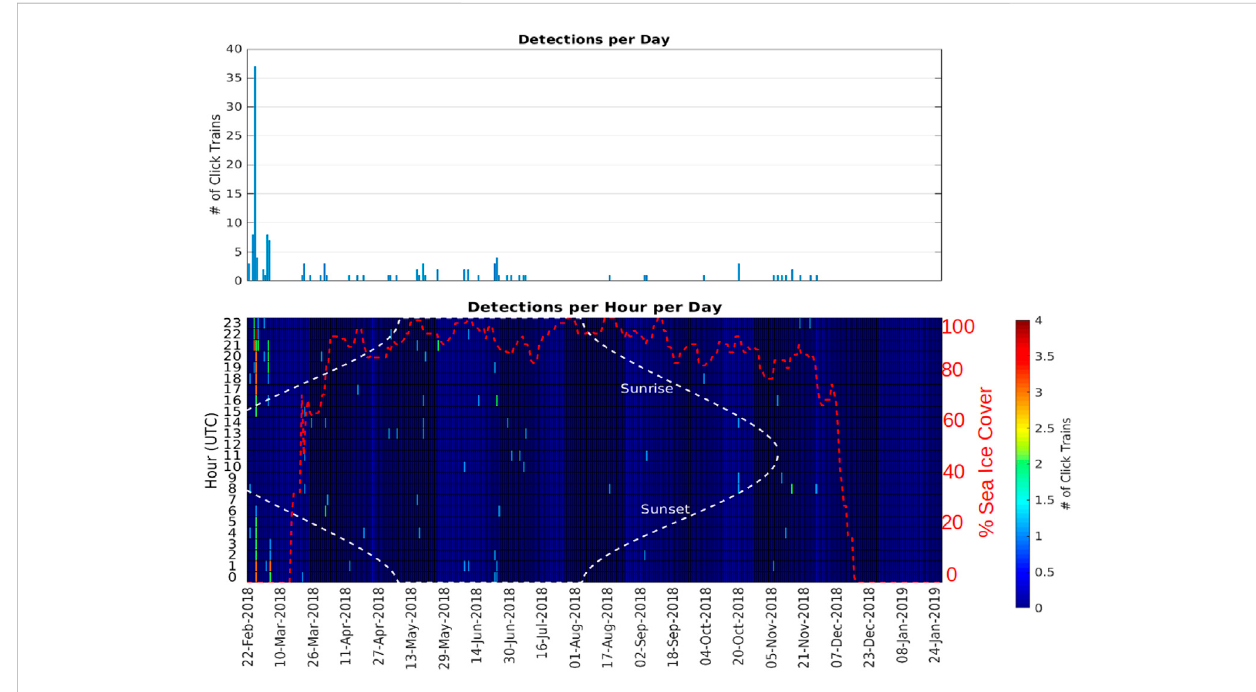
FIGURE 5 Number of echolocation click trains detected at station A1 (Iselin Bank) as a function of day (top panel) and as a function of day and hour of the day (bottom panel). The red dashed line indicates the sea ice percentage cover measured at the location of A1 ( < 15 km range).